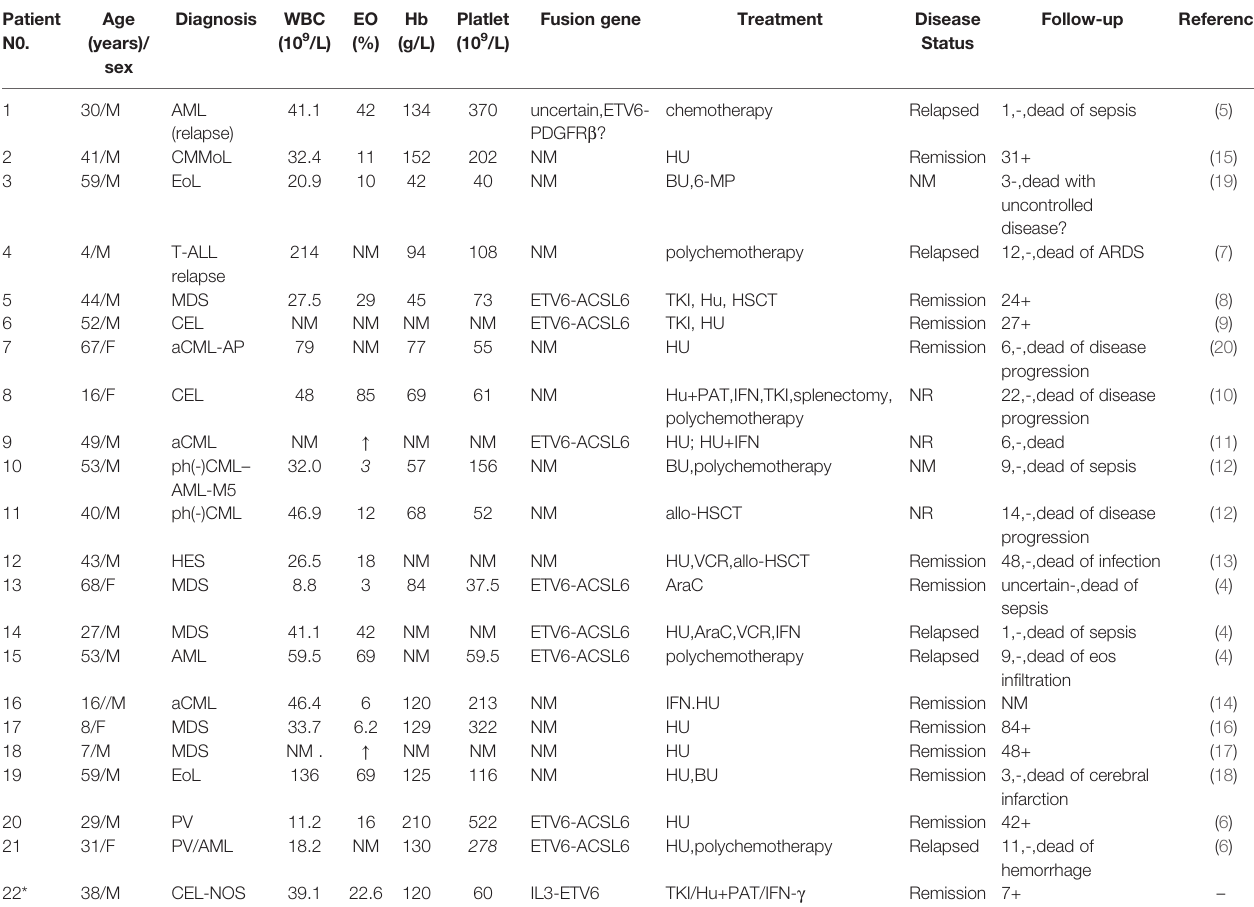
TABLE 2 | Clinical features of 21 patients with t(5; 12) (q31; p13) with cases reported in the literature and the 1 patient in our center. Patient